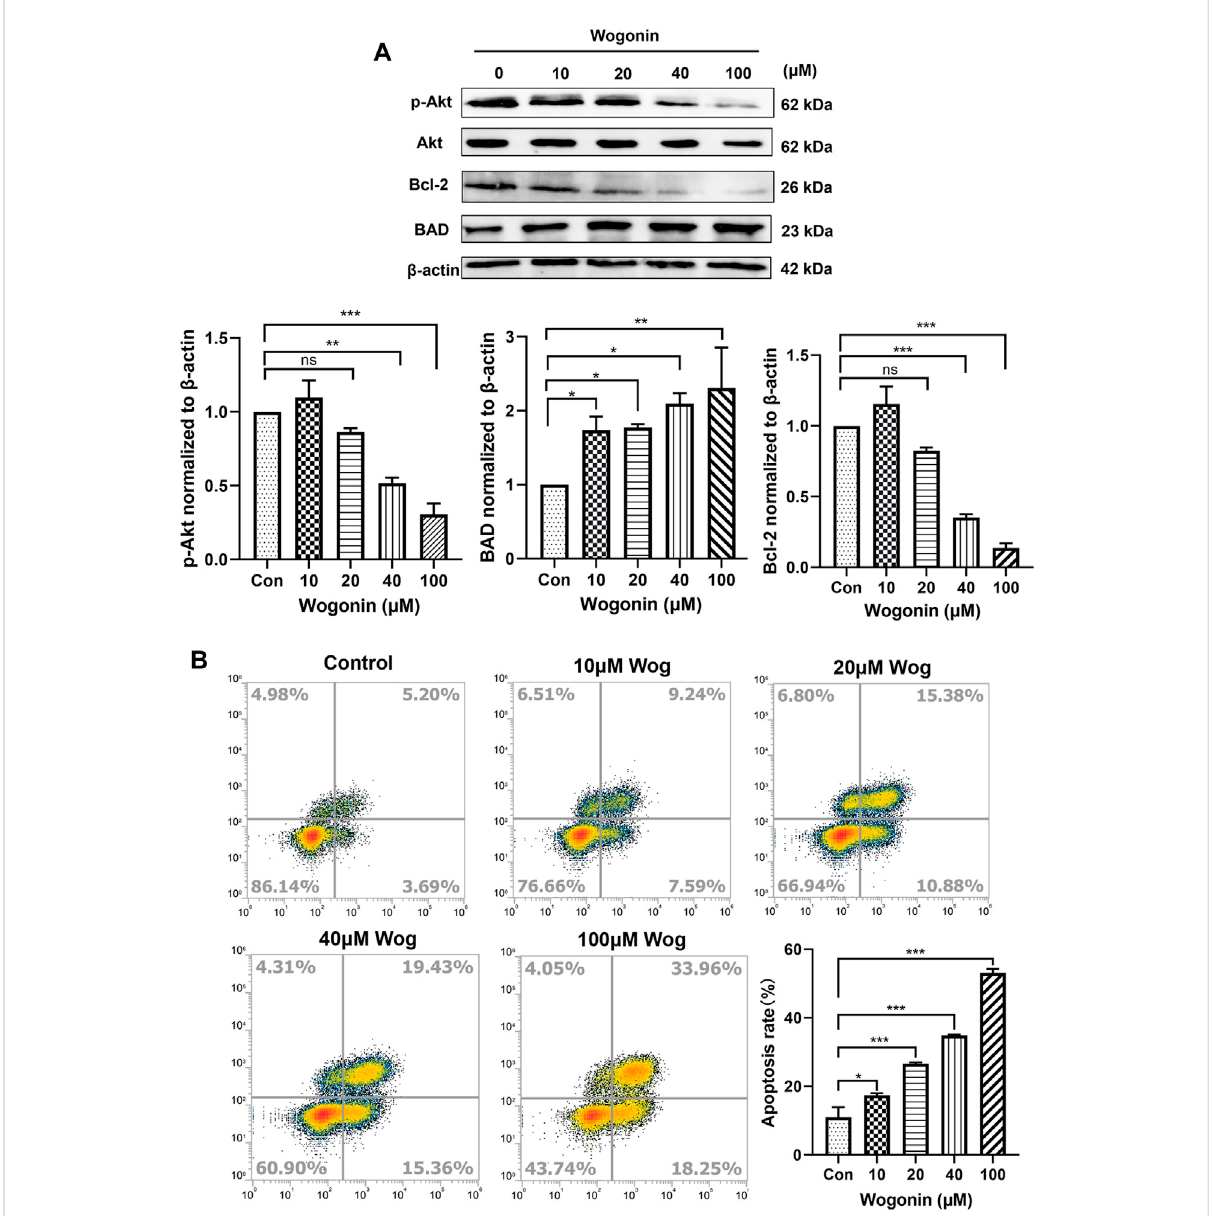
FIGURE 4 WogoninpromotedapoptosisofPanc-1cellsbyinhibitingAktpathway (A) gemcitabine-resistantcelllinePanc-1wastreatedwith10,20,40and 100 μ M wogonin for 72 h, then the protein levels of Akt, p-Akt, BAD and Bcl-2 were detected by westernblot. (B) Flow cytometry was used to detect the apoptosis of Panc-1 cells treated with different concentrations of wogonin for 72 h * p < 0.05, ** p < 0.01, *** p < 0.001 vs.